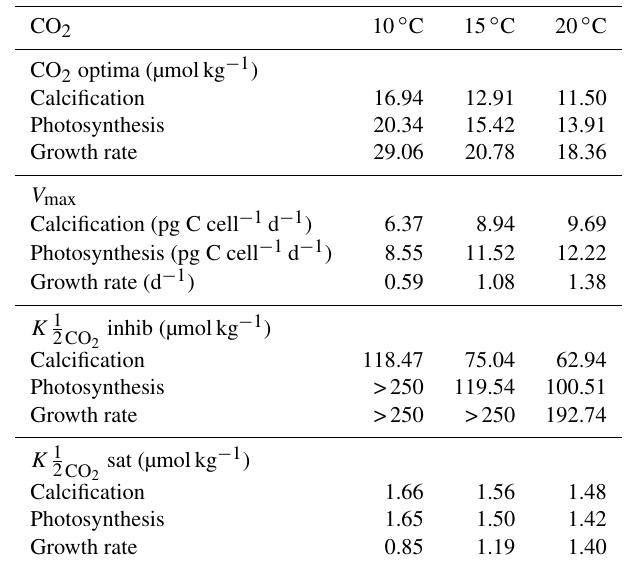
Table 2. Optimum CO 2 concentrations, CO 2 K 1 concentrations and maximum rates ( V max ) at 10, 15 and 20 ◦ C from Eq. (2) fit to CO 2 2 light data at 20 ◦ C in this paper, and E. huxleyi CO 2 data from Sett et al. (2014) at 10, 15 and 20 ◦ C and 150µmolphotonsm − 2 s − 1 light intensity. Note that the CO 2 working range for the equation for this species was 0–250µmolkg − 1 . Values exceeding this range were reported as >250µmolkg − 1